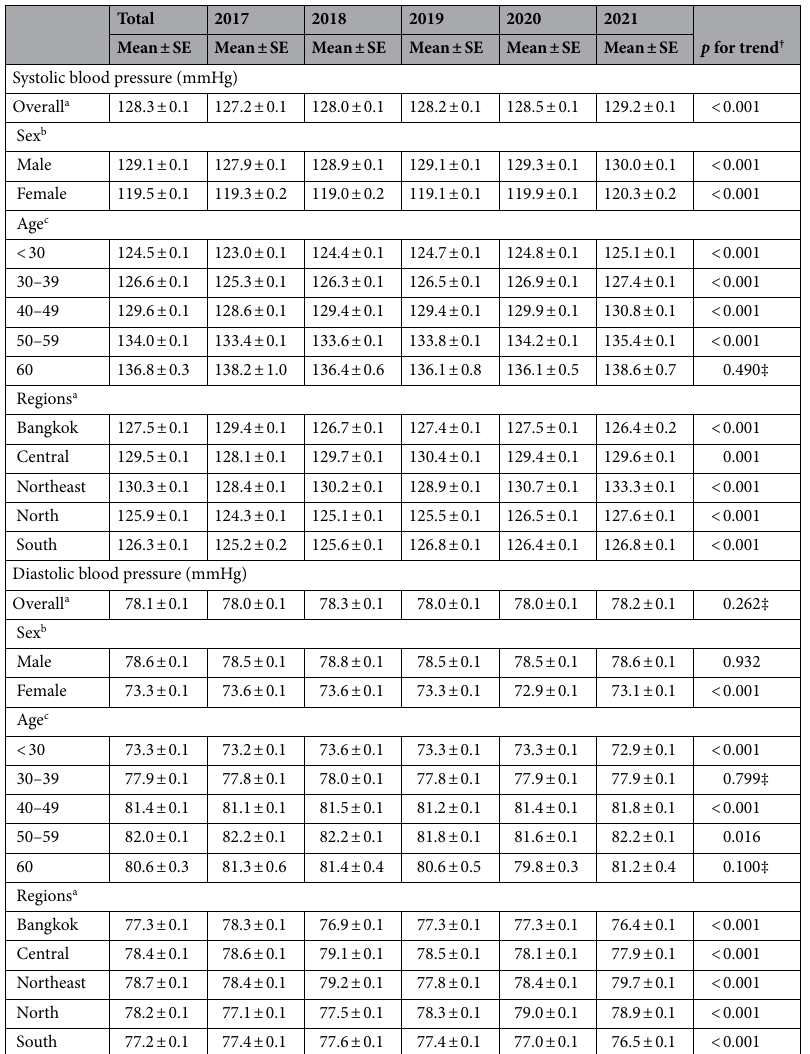
Table 2. Trends in age- and sex-adjusted mean blood pressure among RTA personnel from 2017–2021. SE standard error. † Nonlinear trend was tested first by adding a quadratic term into the regression model. If not significant, linear trend was tested. ‡ Linear trend. a Age- and sex-adjusted mean. b Age-adjusted mean. c Sex- adjusted